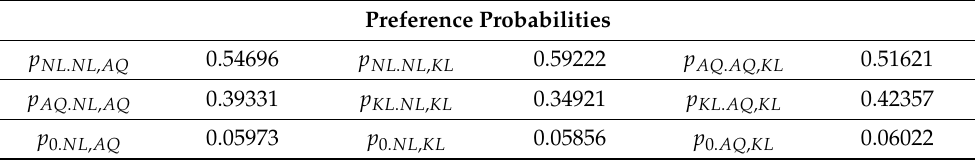
Table 8. Posterior preference probabilities of comparative